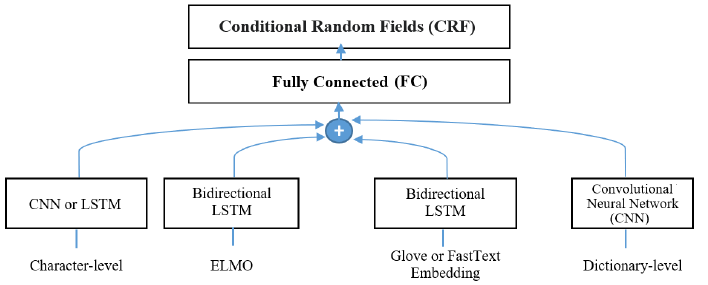
Figure 5. The delayed combination of feature encodings.